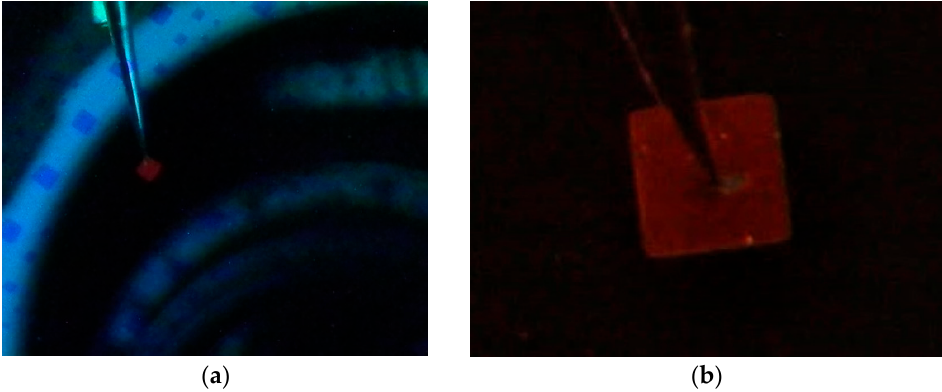
Figure 5. ( a ) PIN + N device of 1 mm 2 emitting red light, ( b ) enlarged image of the same PIN + N device.